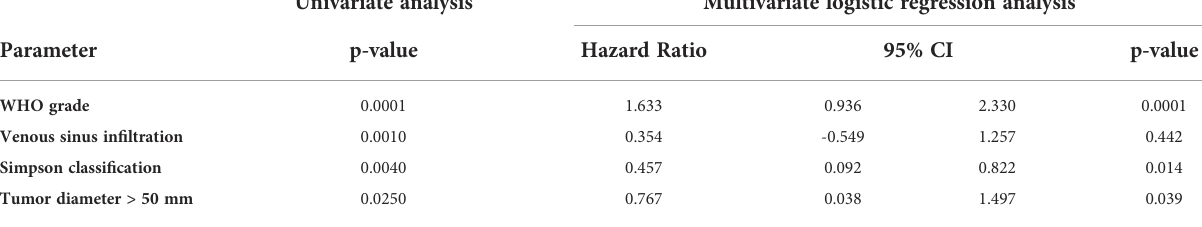
TABLE 4 Univariate (logrank) and multivariate (logistic regression) analysis of factors associated with recurrence – free survival (RFS).